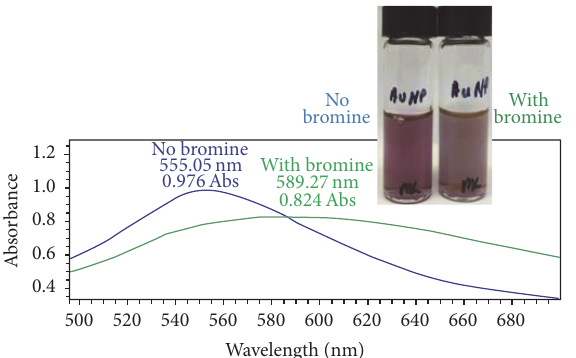
Figure 7: Image of the resulting gold nanoparticle solutions prepared in the absence of KBr (left) and in the presence of 0.075 mM KBr and their corresponding UV-Vis spectra.